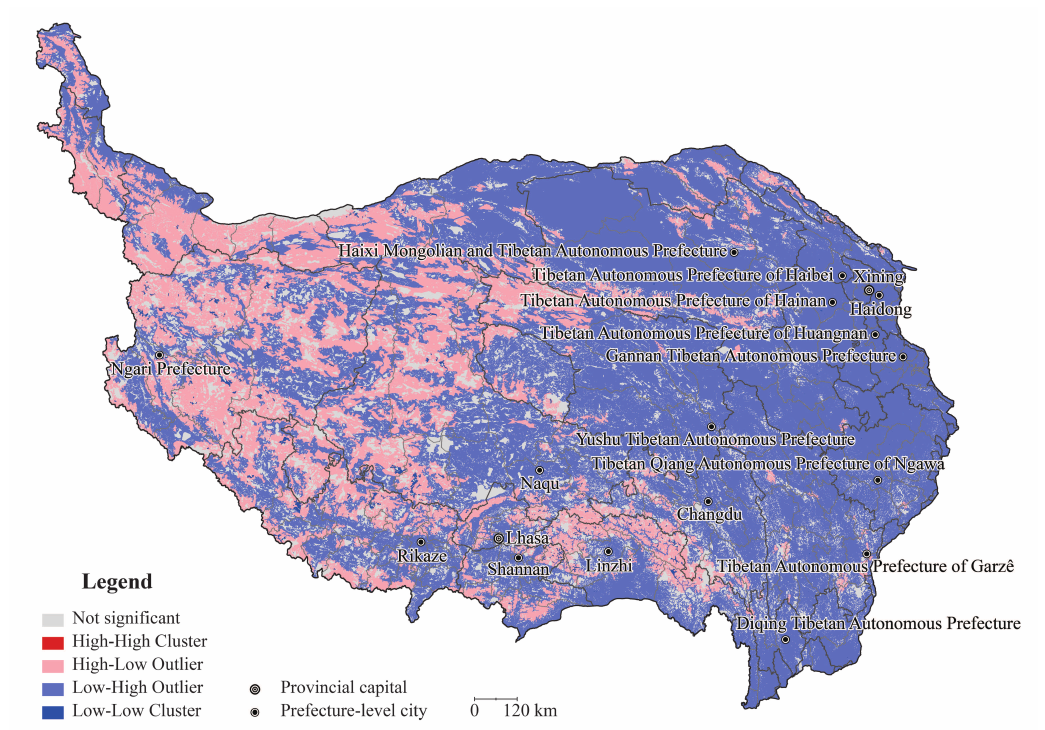
Figure 2. LISA cluster map of the composite variable ( p -value < 0.01).